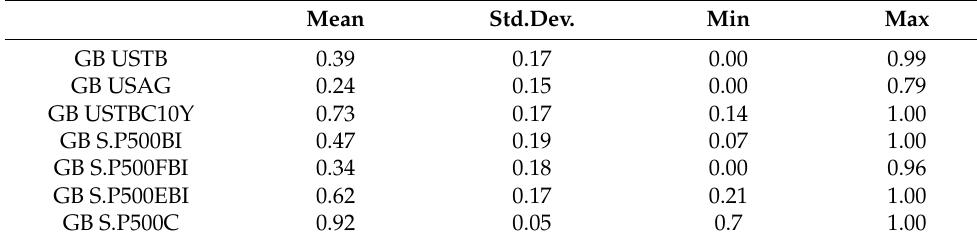
Table 4. Portfolio Weights Summary